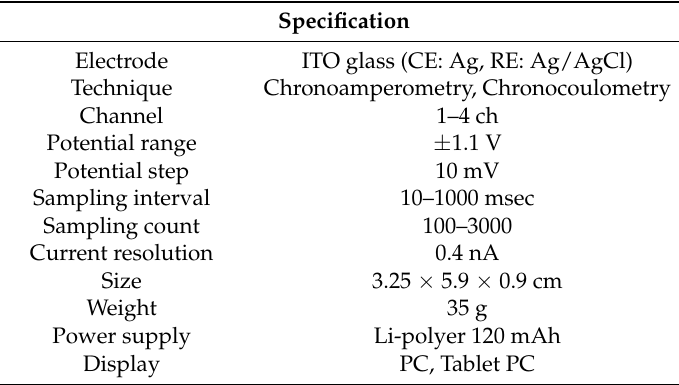
Table 1. System specification.